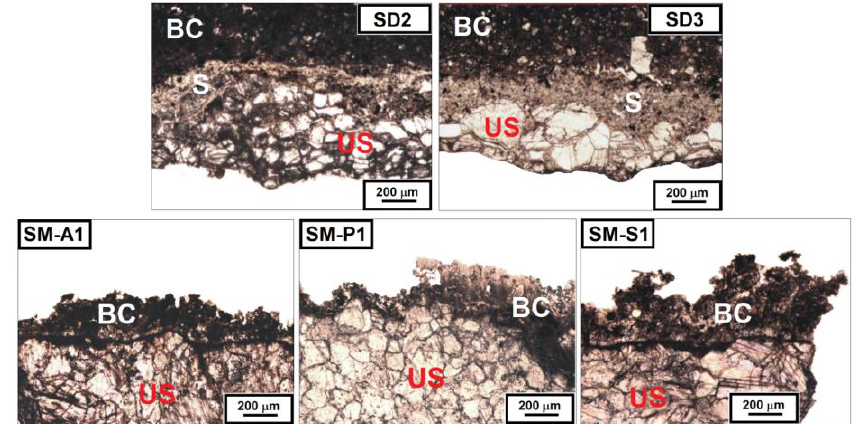
Figure 3. Microphotograph (OM, PPL) showing textural features of some selected marble fragments, with evidence of the black crust layer on the surface. SD2, SD3 are samples from the complex of San Domenico Maggiore , while SM-A1, SM-P1 and SM-S1 were taken from the cloister of San Marcellino e Festo . Notes: unaltered substrate = US; black crust = BC; scialbo =